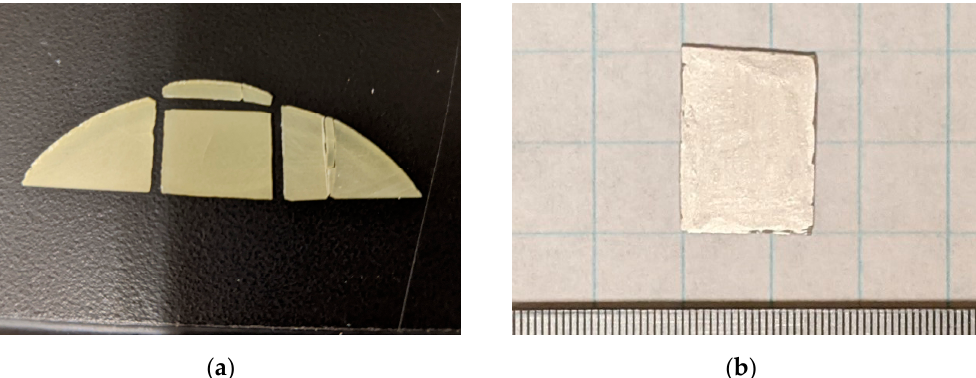
Figure 10. The dielectric sample was prepared from a bulk sample thin slice ( a ), and silver paint was applied to each face to serve as electrodes ( b ).